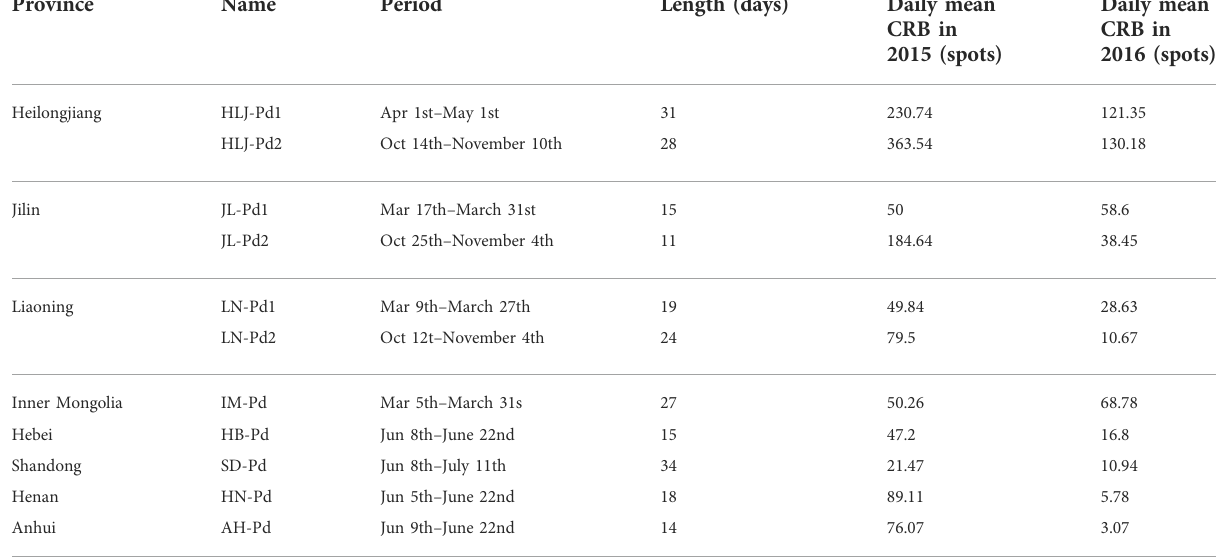
TABLE 1 Selected Pds and daily mean CRB spots in 2015 and